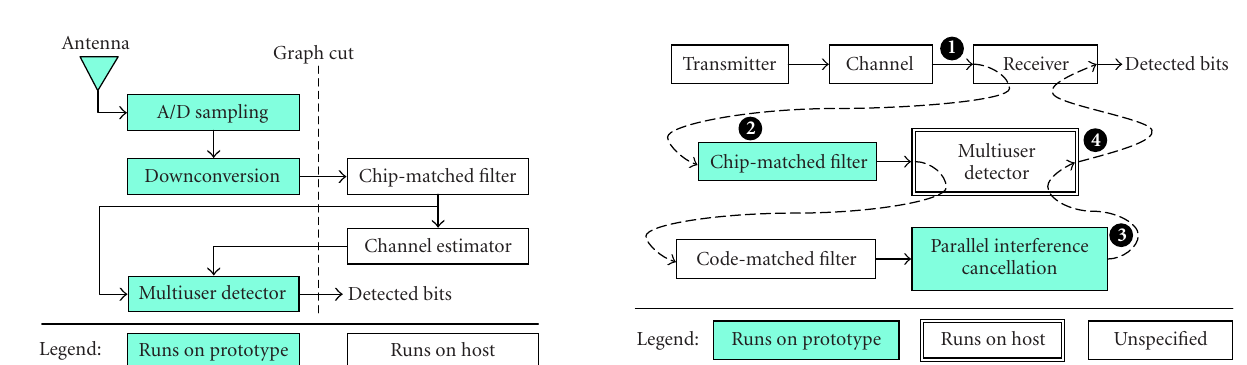
tain an underlying block diagram as illustrated in Figure